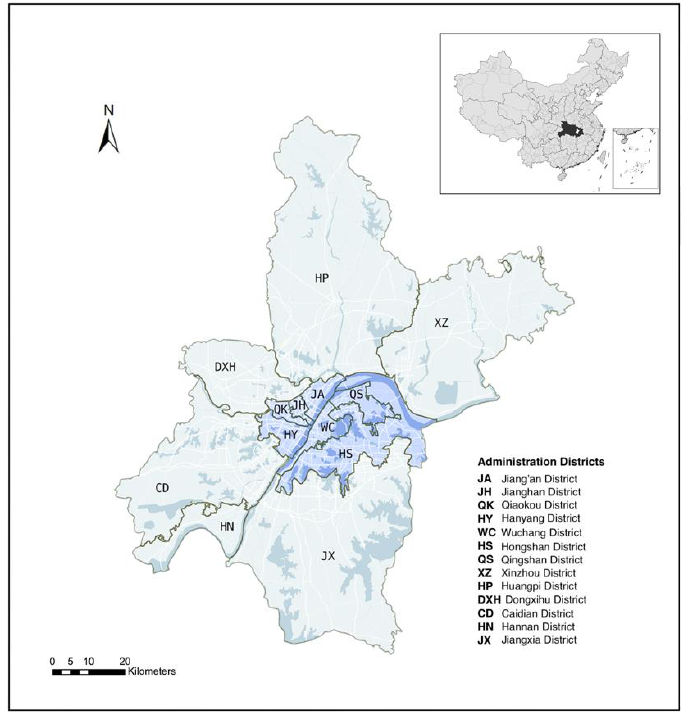
Figure 1. Study area: Wuhan central districts and suburban districts